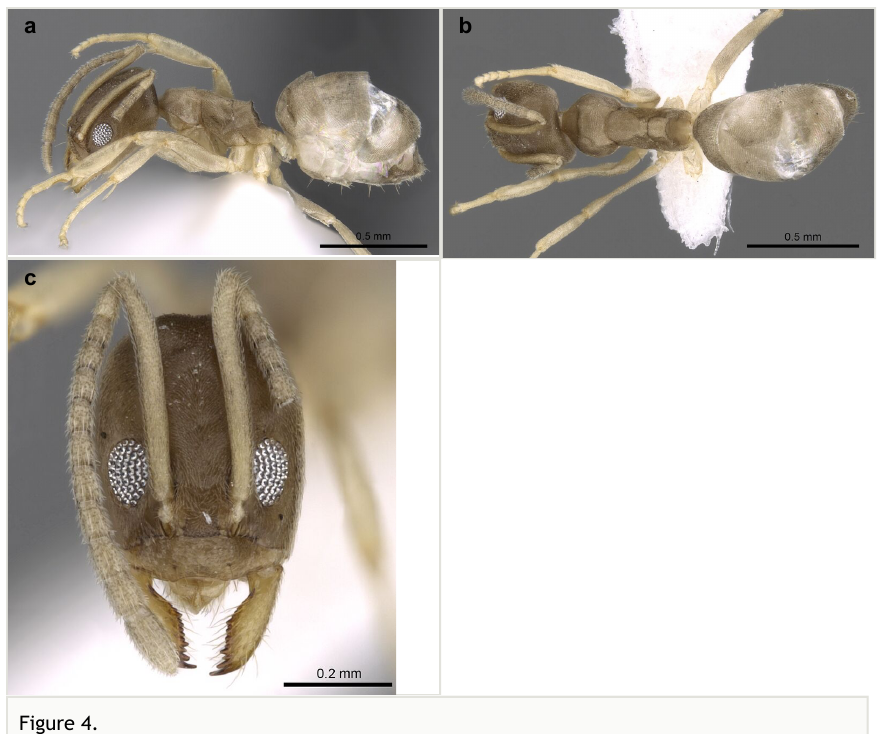
Figure 4. Tapinoma wilsoni , CASENT0280973, Estella Ortega,